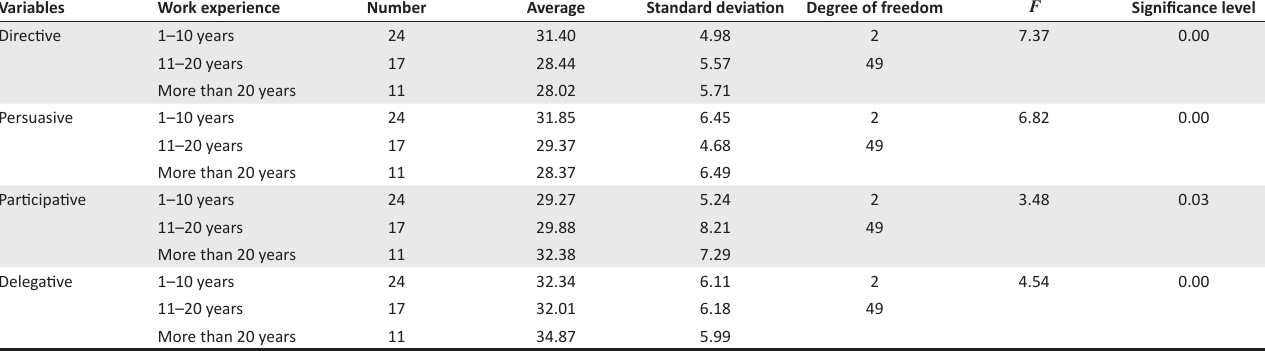
TABLE 4: Results of the one-way analysis of variance of leadership styles, with respect to the managers’ work experience. Variables Work